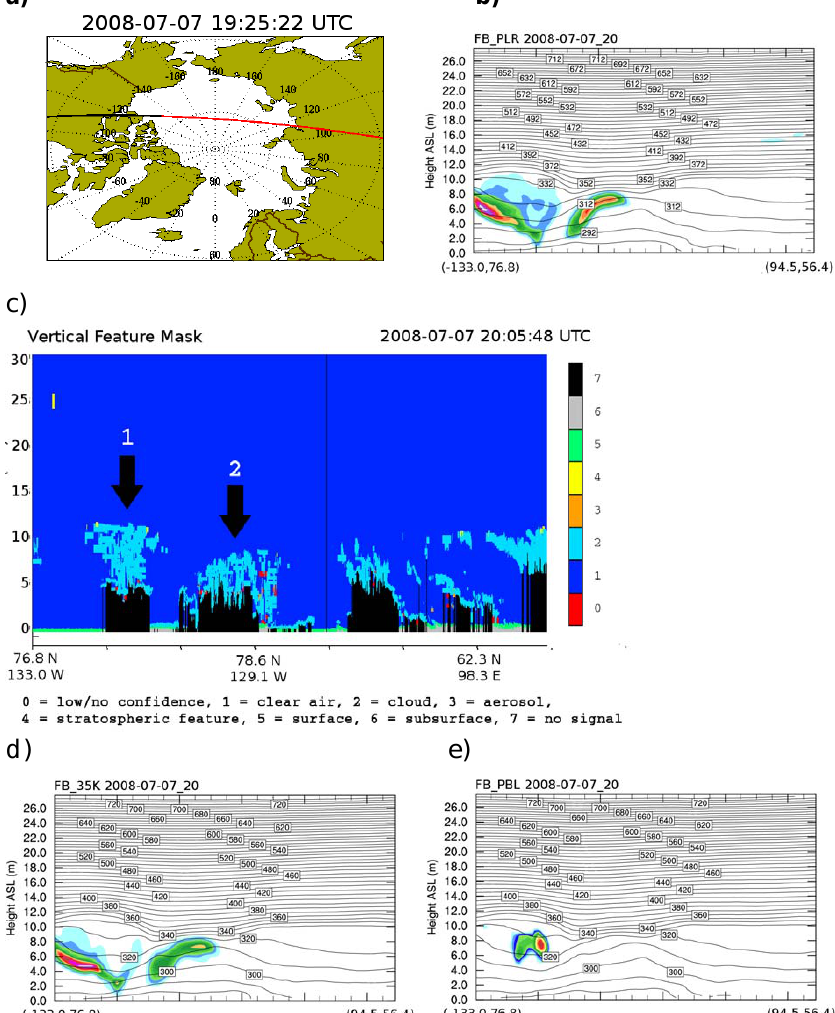
Fig. 14. (a) Map of CALIPSO path at 19:25 UTC 7 July 2008 with analyzed segment near the North Pole in red and (c) the CALIOP vertical feature mask (VFM). Normalized WRF aerosol plumes for (b) FB PLR, (d) FB 35K, and (e) FB PBL along the CALIPSO track. Arrows in Fig. 14. Map of CALIPSO path at 1925 UTC 7 July 2008 with analyzed segment near the North Pole (c) represent features described in the in red and c) the CALIOP vertical feature mask (VFM). Normalized WRF aerosol plumes for b) FB_PLR, d) FB_35K, and e) FB_PBL along the CALIPSO track. Arrows in panel c) represent features described in the text.